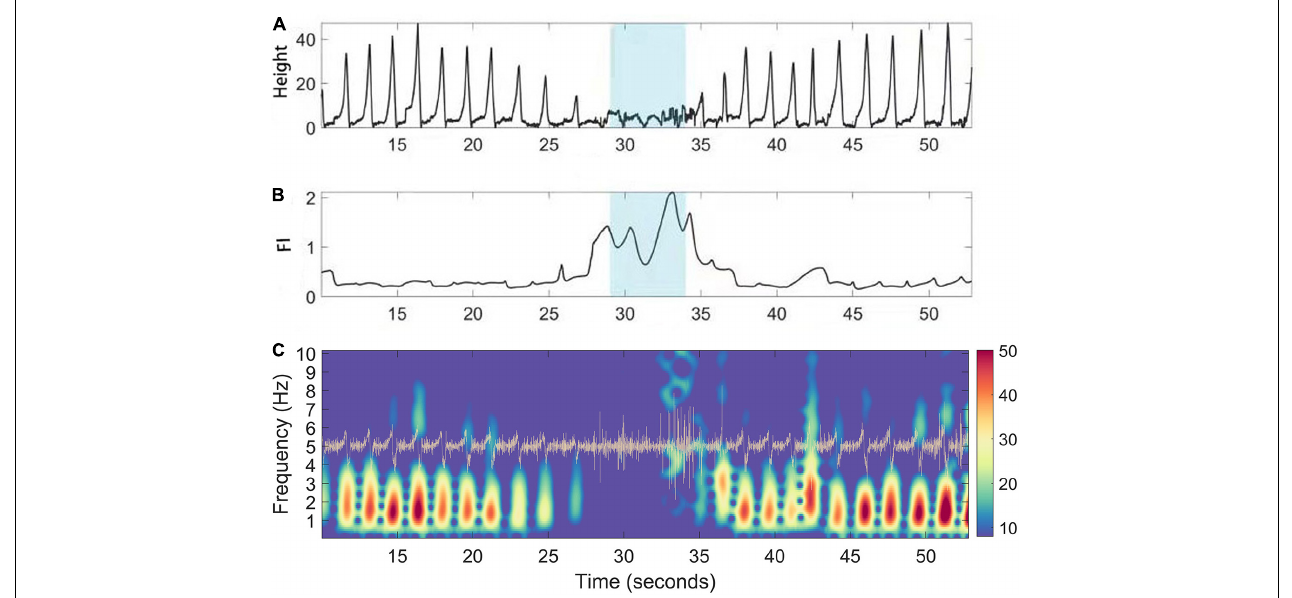
FIGURE 3 | A case illustration of FI (Freeze index) increase during manually labeling freezing phase. (A) Gait positioning data (vertical Z axis) captured by the CODA system of PD patients during walking. (B) The corresponding dynamic fluctuation of FI; Blue area indicates the occurrence time of FOG determined manually. (C) Time frequency representation of the acceleration (trace in yellow) of the raw trace during walking of PD patients. During freezing, the power of the “locomotion band” (0–3 Hz) decreased.